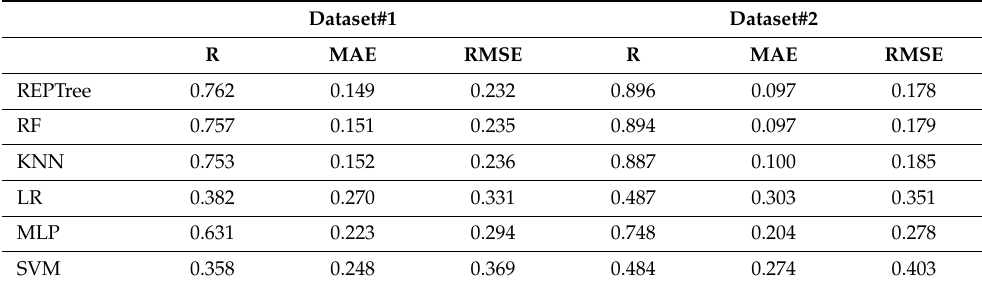
Table 6. Regression analysis results for the LSCC